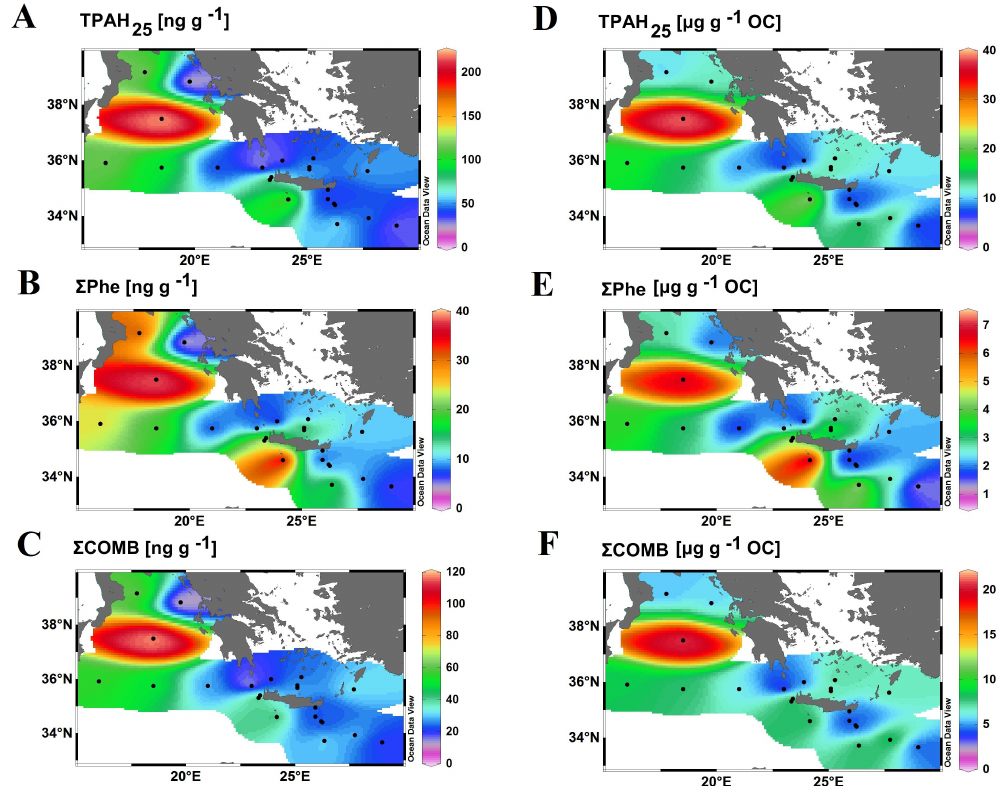
Fig. 4. Spatial contour maps of TPAH 25 , P Phe and P COMB absolute (per dry weight) and their OC-normalized concentrations in deep-sea sediments across the eastern Mediterranean Sea. TPAH 25 , P Phe and P COMB are defined in the